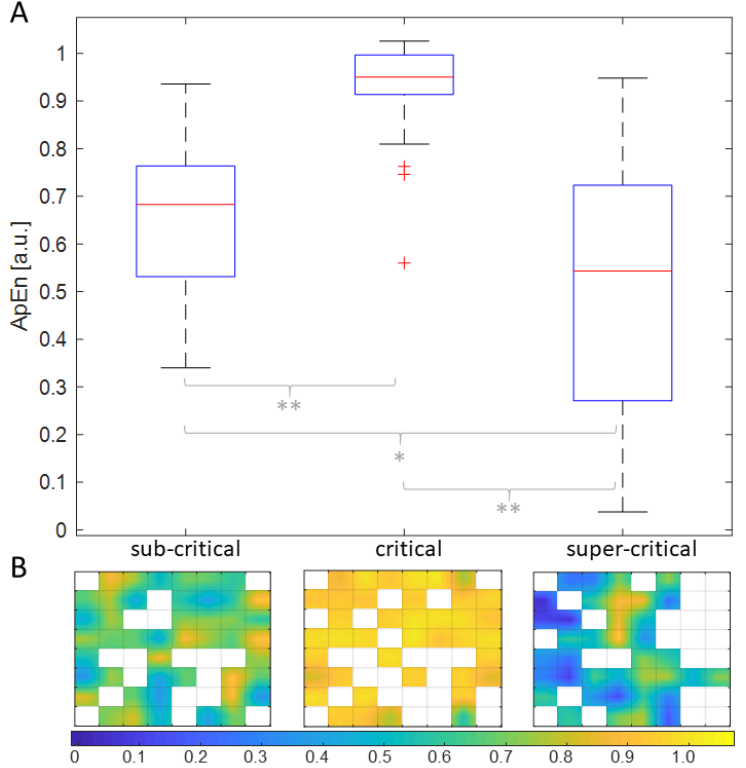
Figure 2. ( A ) Single electrode ApEn distributions estimated from the three cultures used in our experiment correspondent to sub-critical, critical, and super-critical dynamics. The asterisks indicate the statistical difference assessed by a Mann–Whitney U-test followed by a Bonferroni correction ( ∗ and ∗∗ mean p < 0.05 and p < 0.01, respectively). ( B ) Colour maps of the Micro-Electrode Arrays, providing the spatial distribution of the ApEn